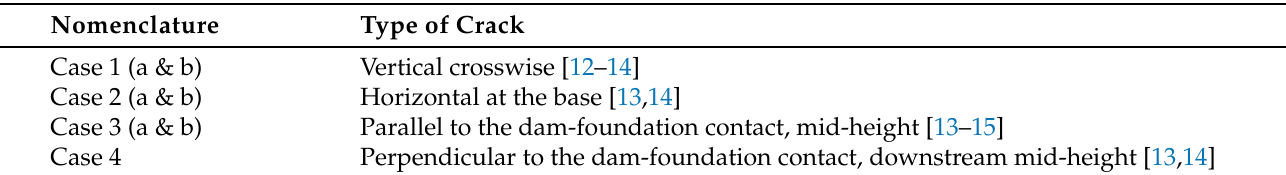
Table 2. Classification according to the type of